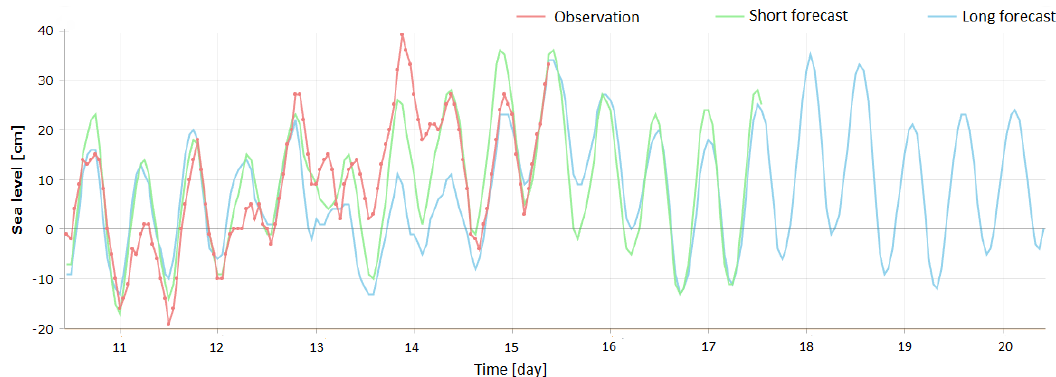
Figure 3. The forecasted and the observed sea level for a period of 10 days (long forecast), 7 days (short forecast), and 5 days (observation) recorded at the Brofjorden measurement station in October 2018. The prediction of the current sea level data was based on the observational data from the SMHI. Because sea level variations can, in general, be considered to be periodic, a moving frame with a sinusoidal shape for the sea level was used to obtain the data for the next two hours (sea level at the present time). The illustration of this procedure is shown in Figure 4.